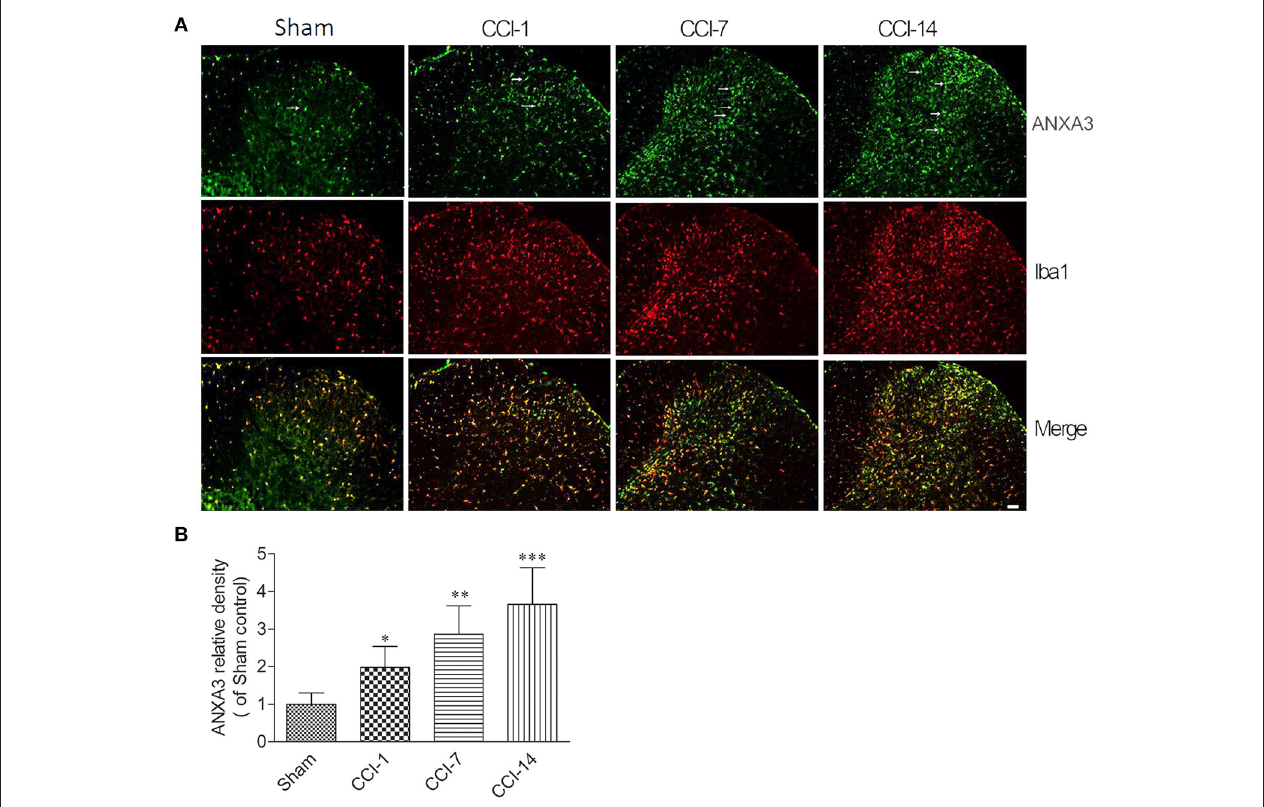
FIGURE 5 | (A) The dynamic expression changes of ANXA3 in the dorsal horn of the spinal cord as assessed by immunofluorescence staining for Annexin A3 (green) and microglia using Iba1 antibody (red). (B) Compare with the sham group, the expression of ANXA3 in the dorsal horn of the spinal cord was increasing from day 1 to day 14 after CCI. Scale bar = 50 µ m (* P < 0.05, ** P < 0.01, *** P < 0.001, n = 5 animals per group).